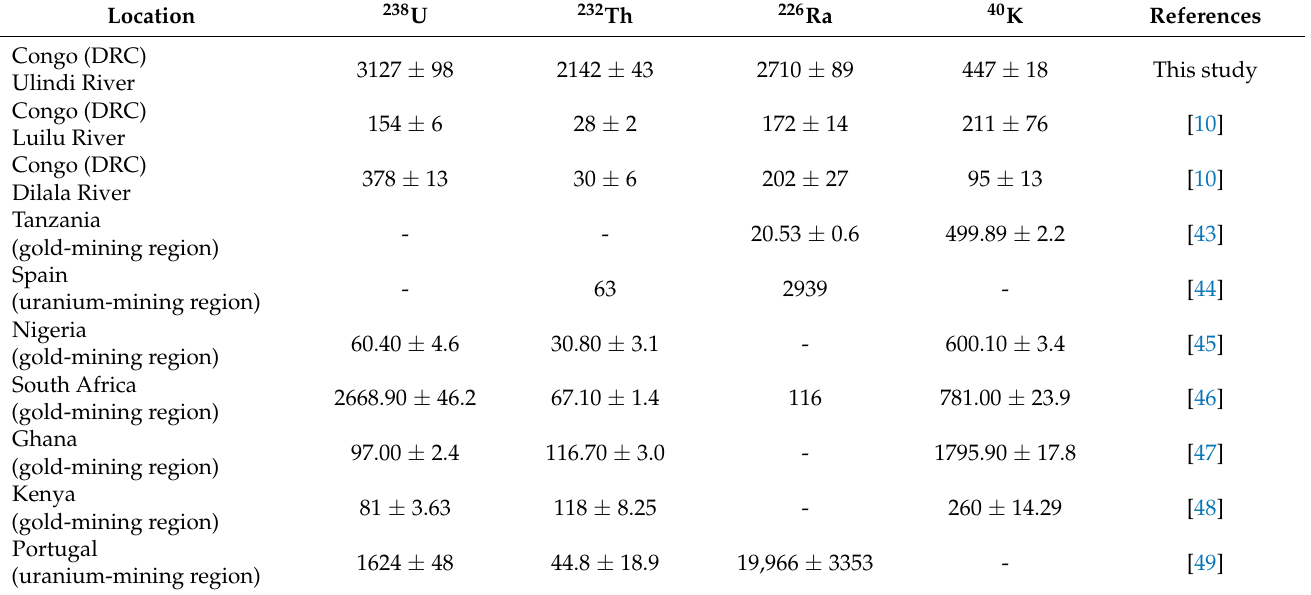
Table 3. Comparison of the average activity concentrations (Bq kg − 1 ) of 238 U, 232 Th, 226 Ra, and 40 K from Ulindi River region with reported concentrations from other regions and from other